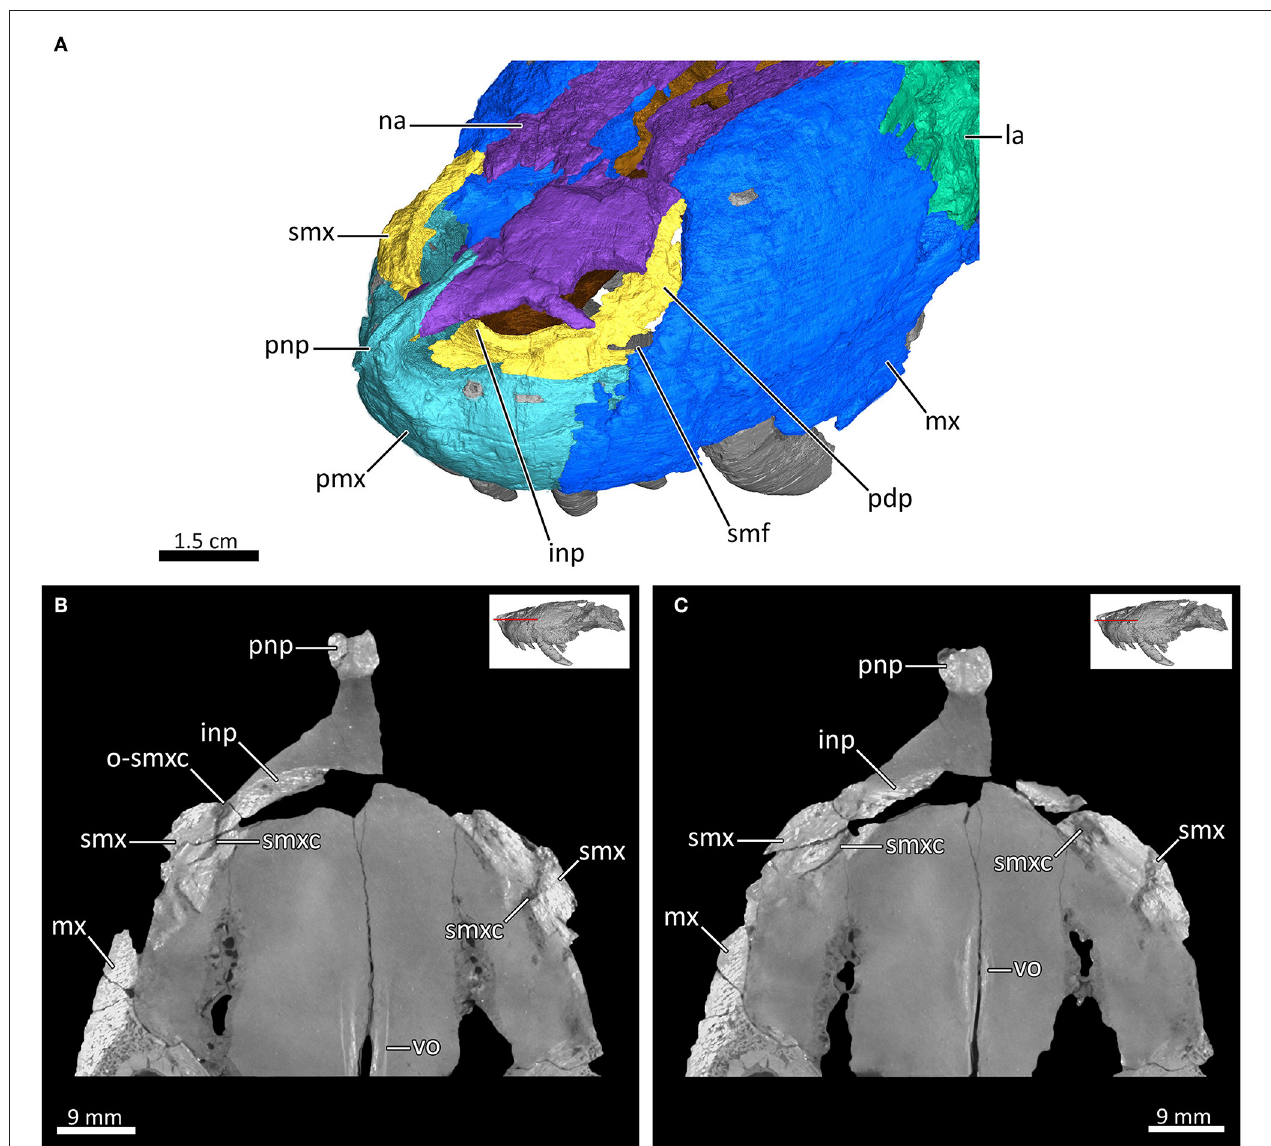
FIGURE 5 | The rostral nasal cavity of MB.R.995. (A) 3D reconstruction of the anterior portion of the snout left anterodorsolateral view. (B,C) Transverse CT sections through the rostral part of the nasal cavity. inp, intranarial process; la, lacrimal; mx, maxilla; na, nasal; o-smxc, opening of the septomaxillary canal; pdp, posterodorsal process of the septomaxilla; pmx, premaxilla; pnp, prenasal process of the premaxilla; smf, septomaxillary foramen; smx, septomaxilla; smxc, septomaxillary canal; vo, vomer.